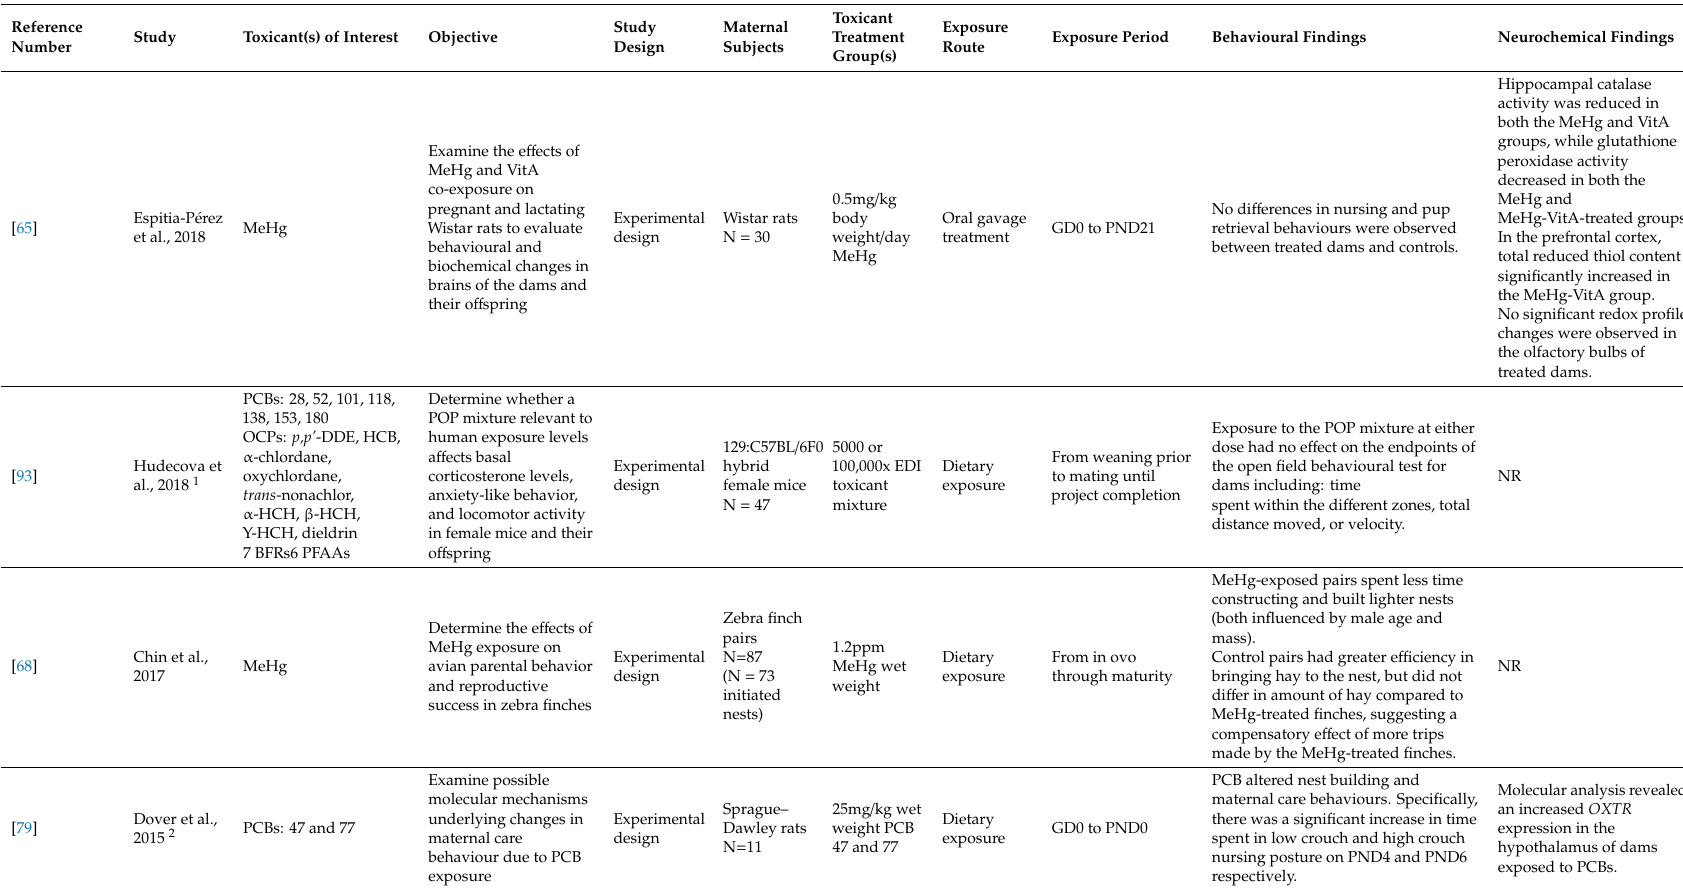
Table 3. Details of studies included in this scoping